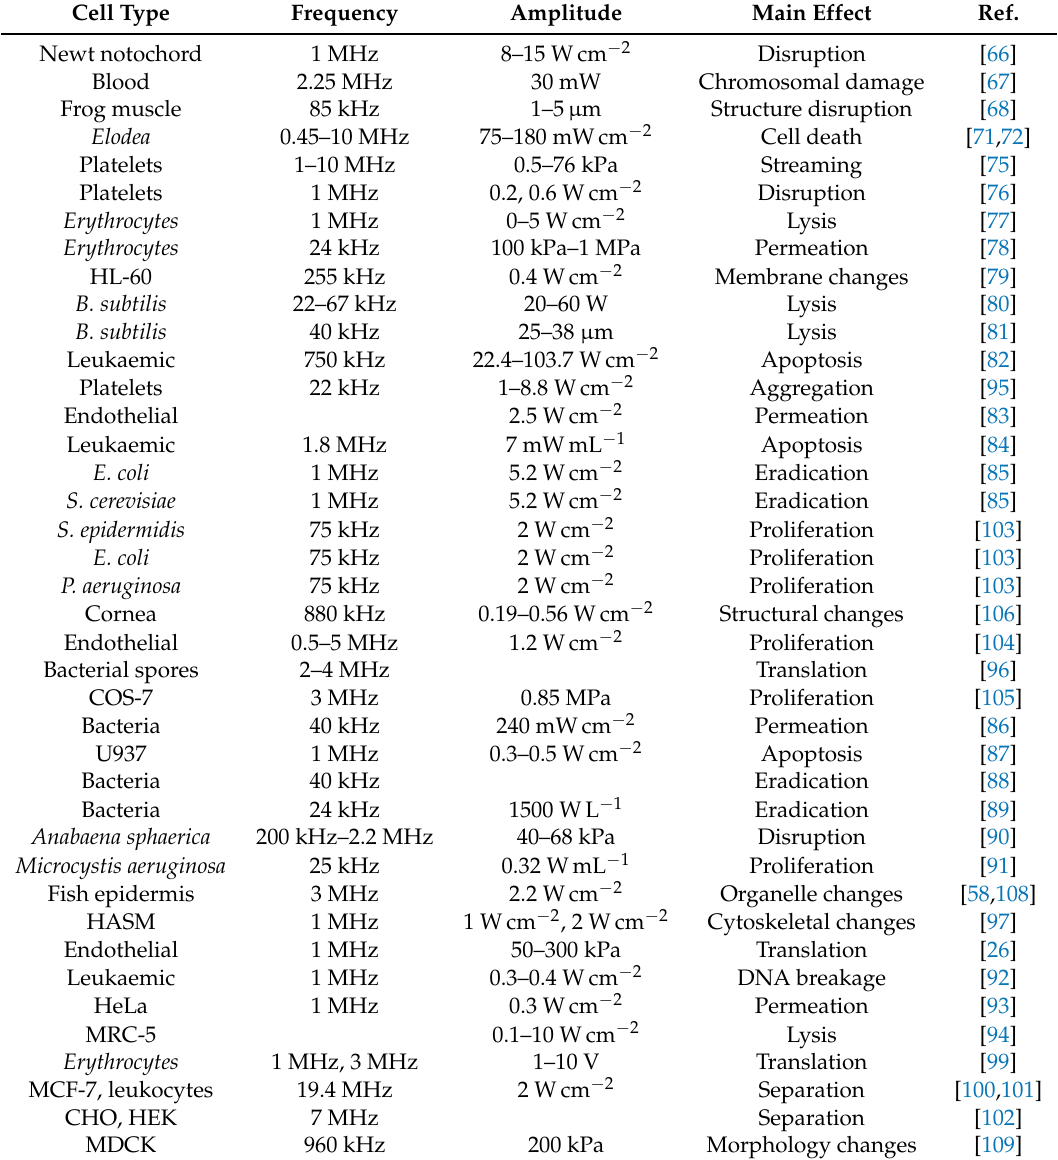
Table 1. Overview of publications on cellular ultrasonics in chronological